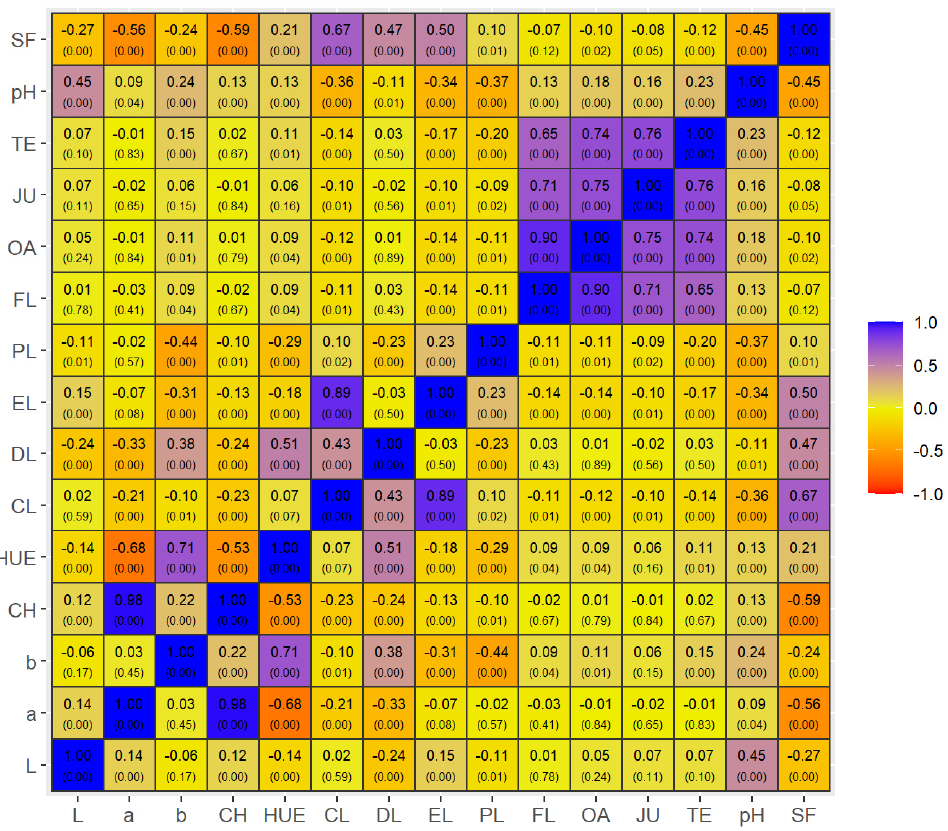
Figure 1. Pearson correlation (uppercase numbers) and significance (lowercase numbers; p -values) between meat quality traits of Nellore bulls. Blue or purple colors means strong or medium positive correlations, while orange or yellow/browned colors means strong or medium negative correlations. Variables: SF = shear force; pH = ultimate pH (48 h post-mortem); TE = sensory tenderness; JU = juiciness; OA = overall acceptance; FL = liking of flavor; PL = purge loss; EL = evaporation loss; DL = drip loss; CL = total cooking losses; HUE = real color; CH = chromaticity; b = yellowness; a = redness; and L = lightness.